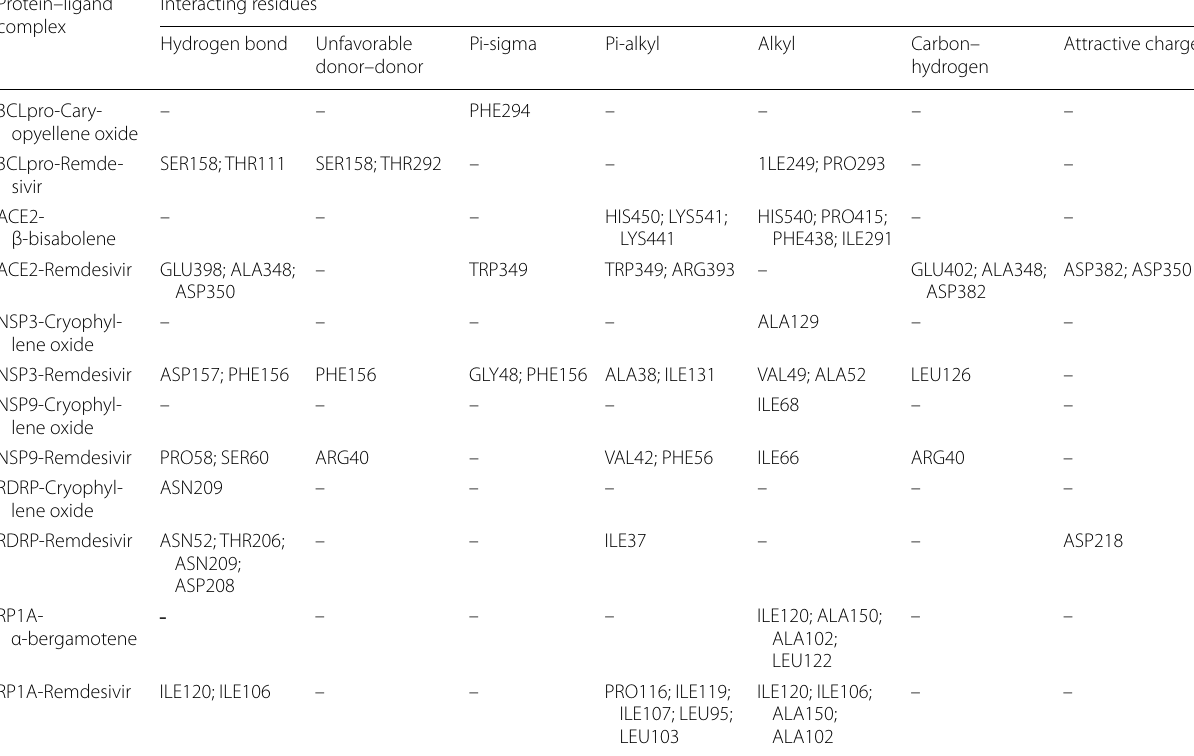
Table 4 Protein residue interactions with the compounds and